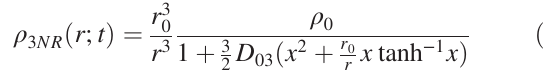
FIG. 6. Analysis of the functions in r 0 ¼ r x 2 ¼ 1 − r 0 has a range [0, 1] with is x ¼ 0 occurring at t ¼ 0 and x ¼ 1 occurring at t ¼ ∞ . The term p 1 ð x Þ is plotted in (a) and shows r that p 1 ð x Þ is greater than 0 for x > 0 . The term p 2 decreases as ζ is